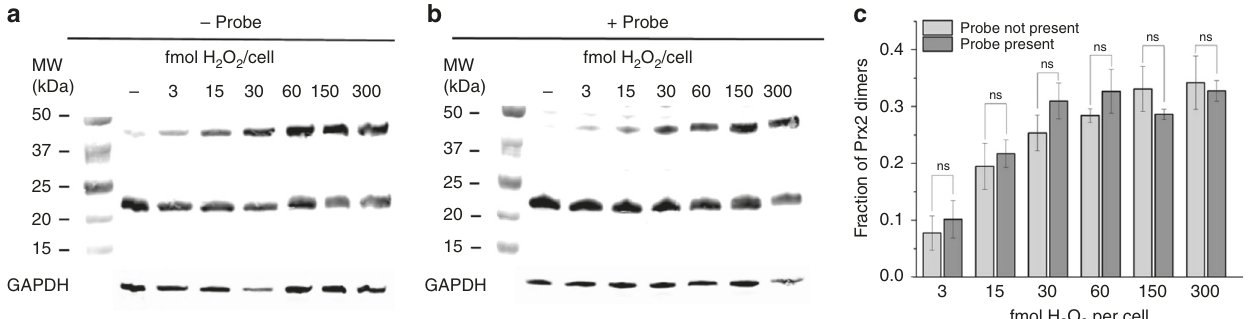
Fig. 3 Effect of fl uorescent Prx2 probe on H 2 O 2 peroxidase activity of endogenous Prx2 in the cytosol of HeLa cells. a Endogenous Prx2 oxidation in HeLa cells without the fl uorescent probe in response to various amounts of H 2 O 2 . b Endogenous Prx2 oxidation in HeLa cells stably expressing the probe in response to the same amounts of H 2 O 2 . Mol per cell values correspond to 2 mL of 20, 10, 5, 1, or 0 μ M H 2 O 2 added extracellularly to 7 × 10 5 adherent cells. Endogenous glyceraldehyde 3-phosphate dehydrogenase (GAPDH) was simultaneously analyzed in these blots to assess the uniformity of lysate loading and protein content. Western blot images are re fl ective of three biological replicates. c Calculated fraction of dimeric Prx2 in cytosol of HeLa cells in response to listed amounts of H 2 O 2 . For each amount of H 2 O 2 , the fraction of dimeric Prx2 was calculated from the intensity of the dimer band divided by the sum of the intensities in the dimer and monomer bands, minus the fraction of the dimeric Prx2 in the lane with no H 2 O 2 (which re fl ects the amount of lysis-induced oxidation in the sample). Bar graph plus dot plot shown in Supplementary Fig. 23. Data points represent mean value ± S.E.M for three biological replicates. ns: not signi fi cant at p < 0.02; two-tailed student ’ s t indicates that expression of the probe does not shift the onset of native Prx2 dimerization.